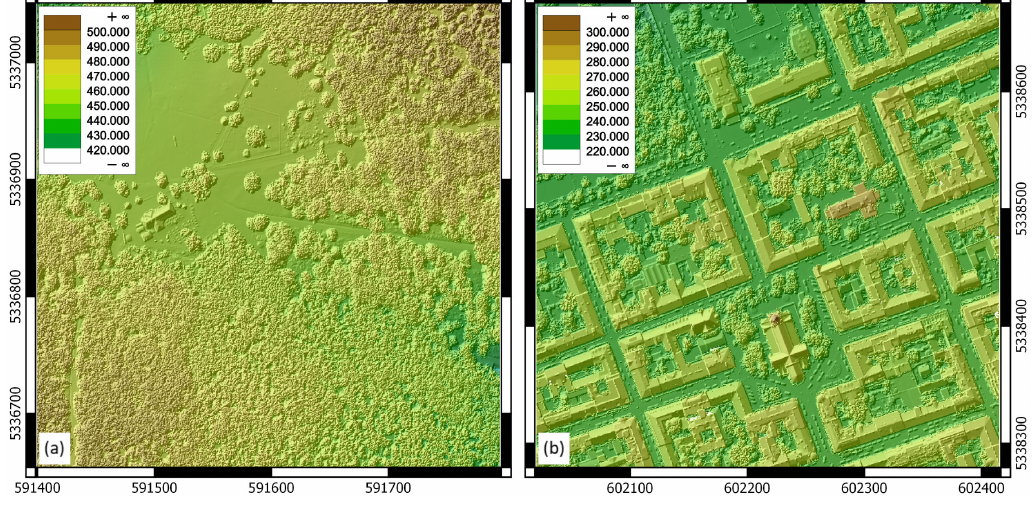
Figure 3. Shaded relief map of test areas superimposed with color coded height map, (a) forest, (b)